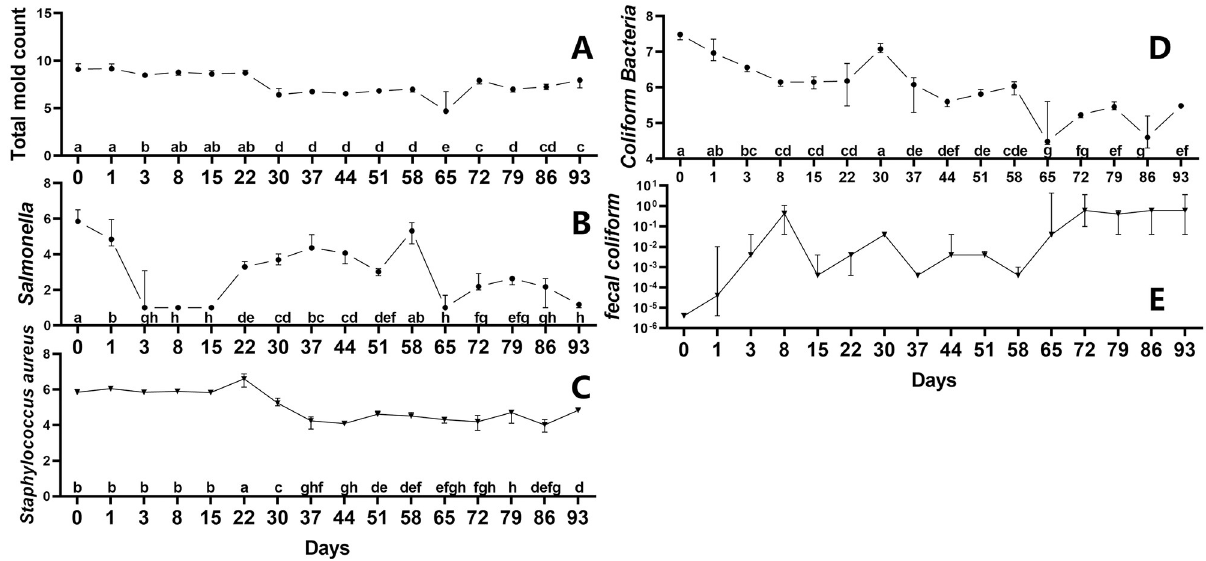
Fig 1. Changes of pathogenic bacteria and fecal coliform in ectopic fermentation bed. Count of total mold (A), Salmonella (B), Staphylococcus aureus (C), Coliform Bacteria (D) and fecal coliform (E) were assessed during the EFS process. Statistical assessment was carried out with one-way ANOVA followed by post hoc test using Dunn’s multiple comparison test. Values with different letters are significantly different at P <